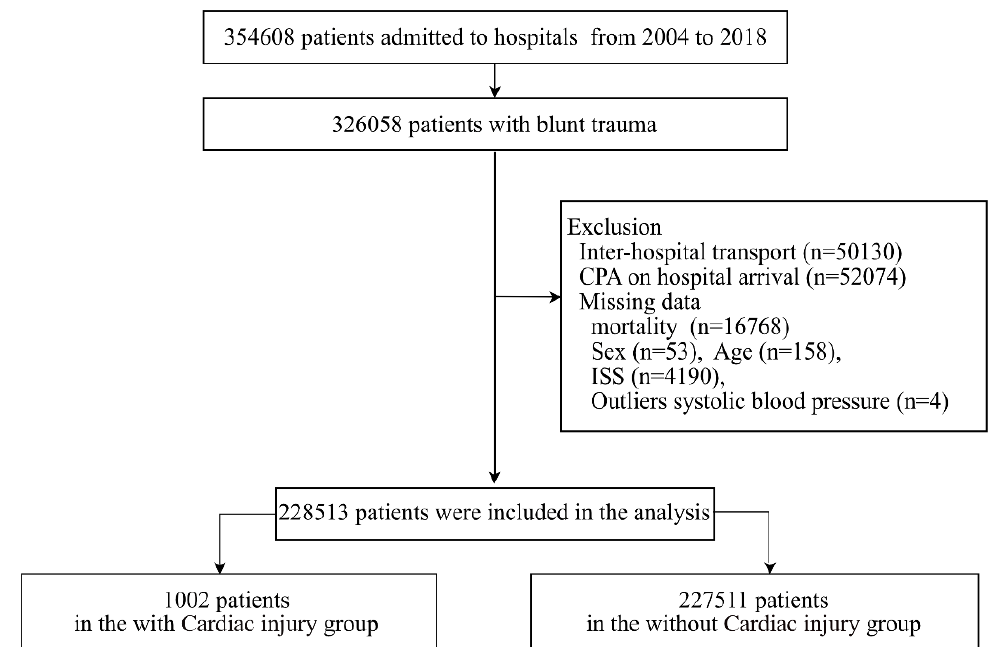
Figure 1. Flowchart of patient selection from the Japan Trauma Data Bank. Table 1. Characteristics of the cardiac injury and non-cardiac injury groups.